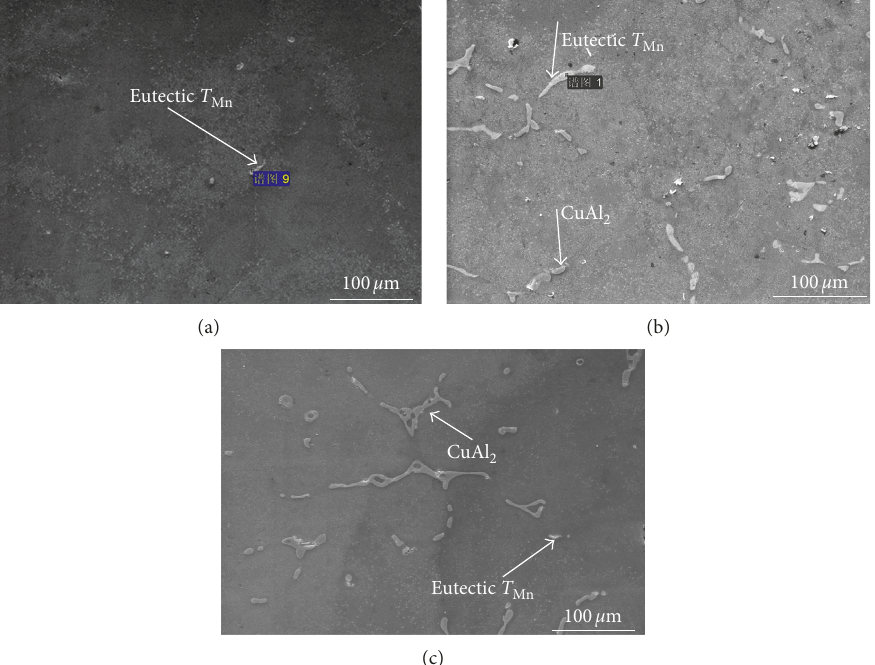
Figure 8: SEM images showing the variation of eutectic phases after solution treatment: (a) A